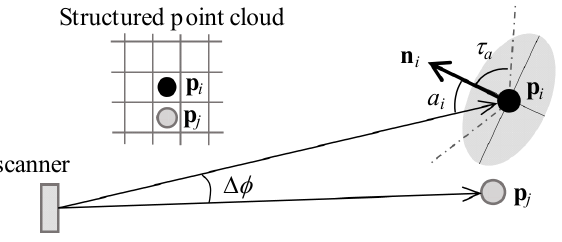
Figure 1. Neighbor point identification and incident